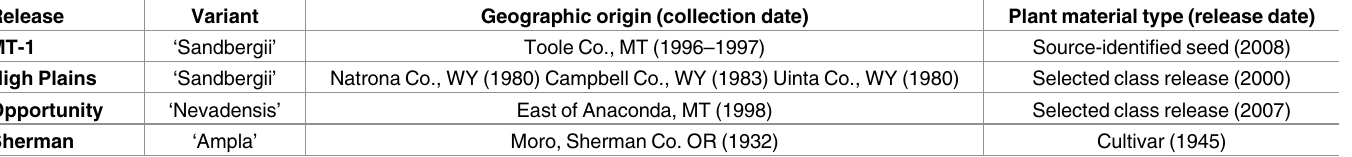
Table 1. Poa secunda commercialreleasesource information.